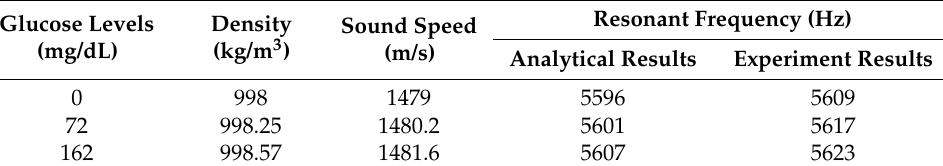
Table 2. Parameters and resonant frequencies for different practical glucose levels.